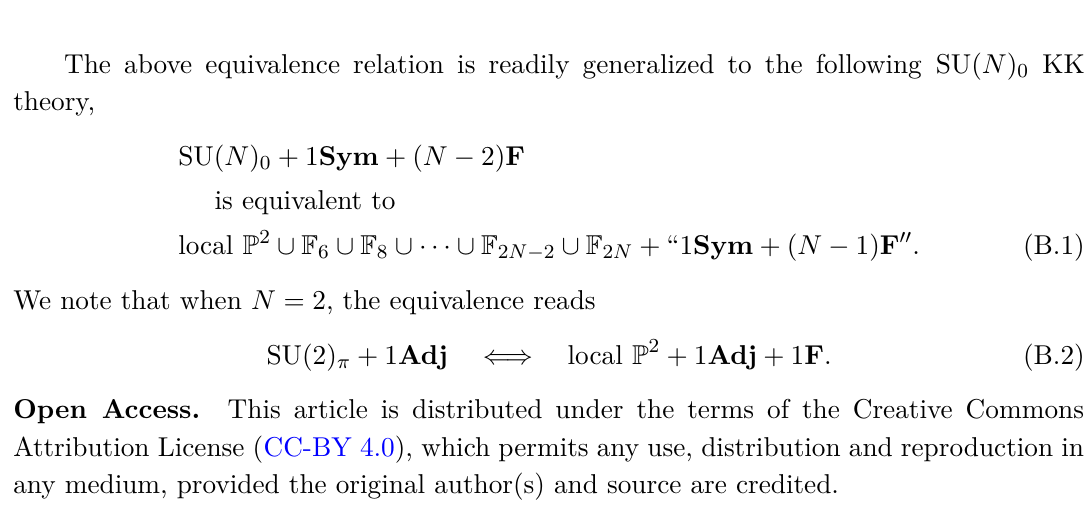
Figure 19. From 5-brane web for local P 2 ∪ F 6 + “1 Sym + 2 F ” to that for SU(3) 0 + 1 Sym + 1 F . (a) A 5-brane web for local P 2 ∪ F 6 + “1 Sym + 2 F ”. (b) Locating D5-brane on the right-hand side of O 7 + to the left. (c) Pull down the (0 , 1) 7-brane (in red) in figure (b) toward the cut of O 7 + and perform an SL(2 , Z ) transformation. (d) With some mass deformations, Hanany-Witten move with the ( − 3 , 1) 7-brane in figure (c) which gives rise to an 5-brane web for SU(3) 0 + 1 Sym + 1 F . (d) A little deformation leading to the same web for SU(3) 0 + 1 Sym + 1 F given in figure